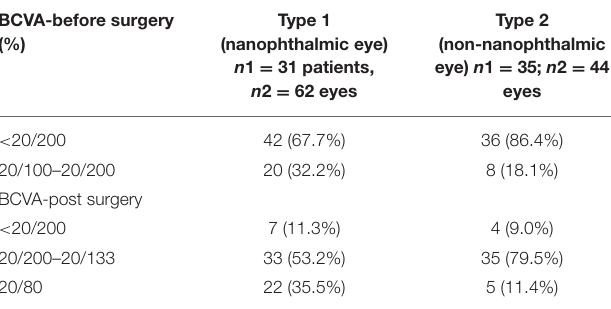
TABLE 2 | Change in best corrected visual acuity (BCVA) of patients with UES before- and post-surgery to the last follow-up visit available. BCVA-before surgery